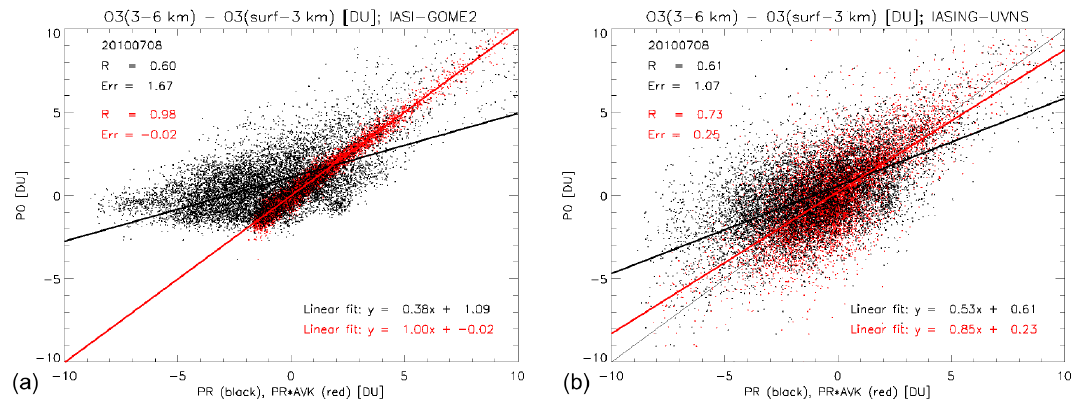
Figure 12. Same data as in Fig. 11. IASI + GOME-2 (a) and IASI-NG + UVNS (b) pseudo-observations (POs, y axis) versus pseudo-reality (PR, black, x axis) and AVK-smoothed pseudo-reality (PR × AVK, red, x axis). Linear correlation coefficient, mean error and linear fit equation are reported in the